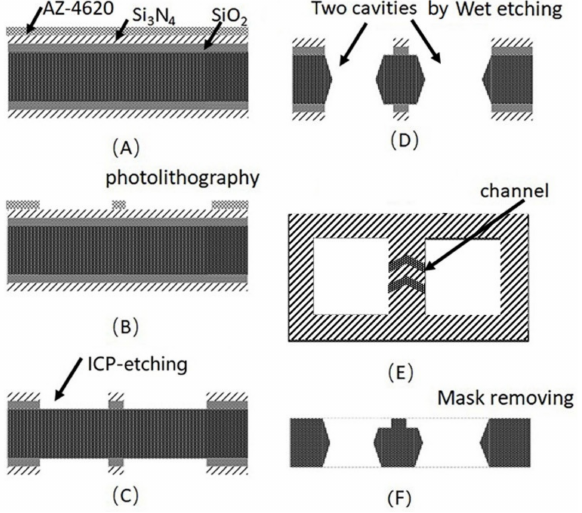
Figure 2. Fabrication process of the two cavities of the silicon wafer with vapor cell ( A ) mask depo- sition, ( B ) photolithography, ( C ) ICP-etching for Si 3 N 4 and SiO 2 . ( D ) Two cavities by anisotropical etching. ( E ) The microchannel between two cavities. ( F ) Si 3 N 4 and SiO 2